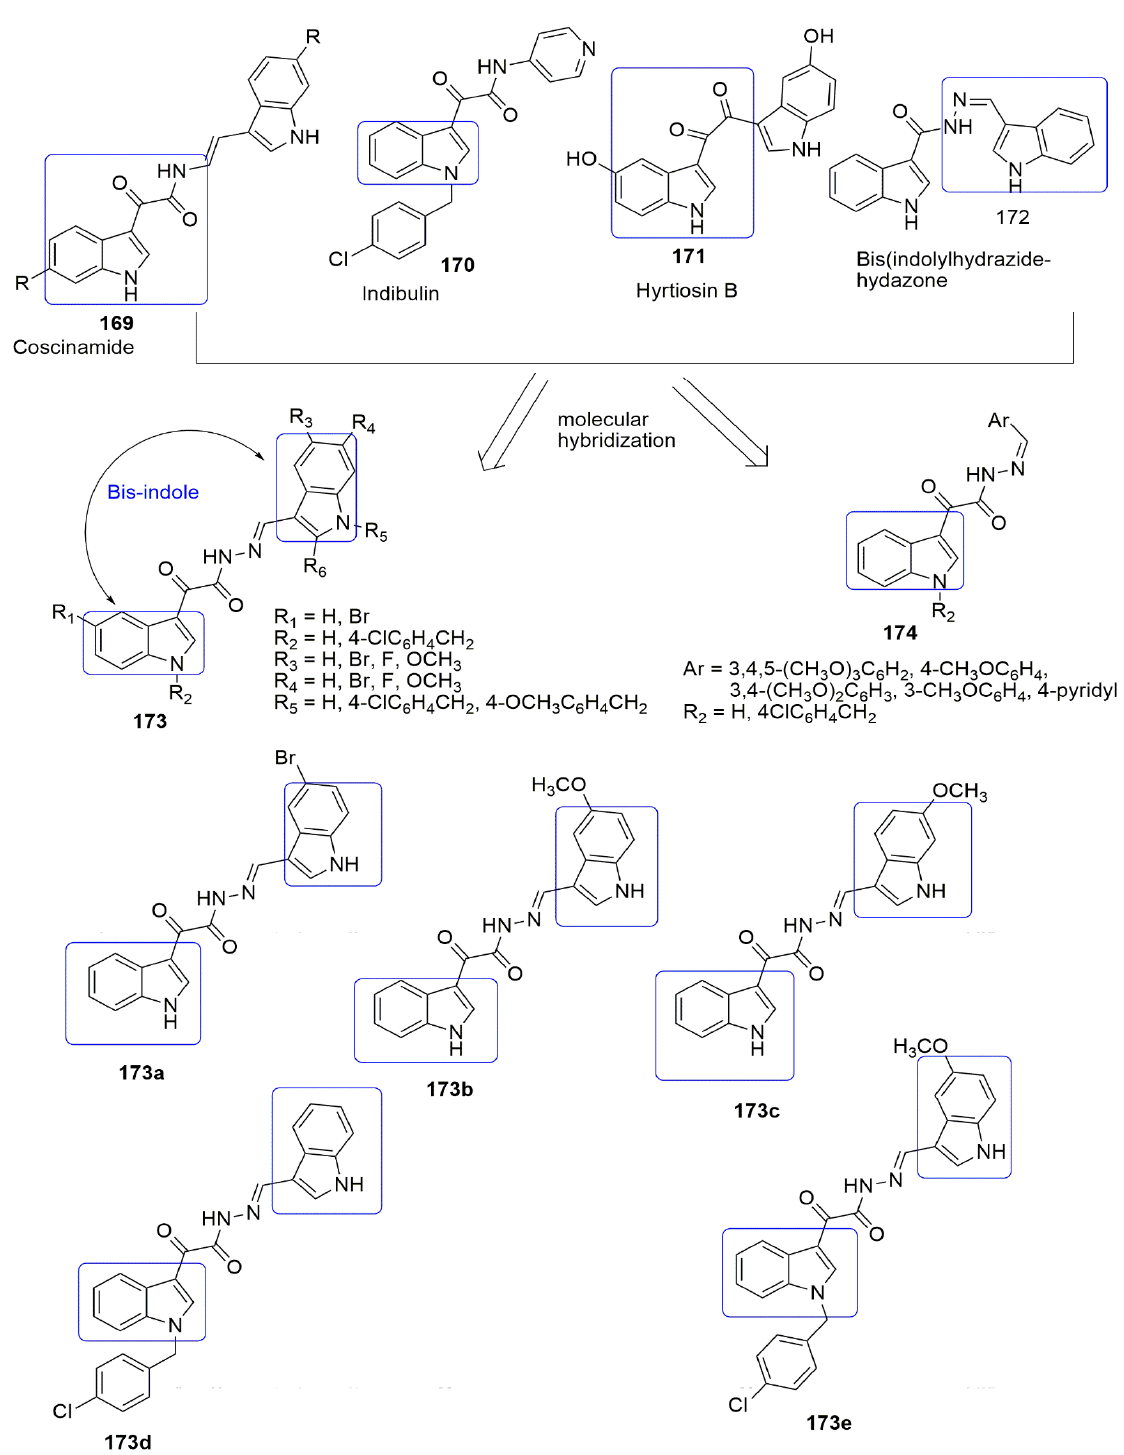
Figure 45. Chemical structures of bis(indolyl)ketohydrazide-hydrazones conjugates tested against different panel of cancer cell lines.